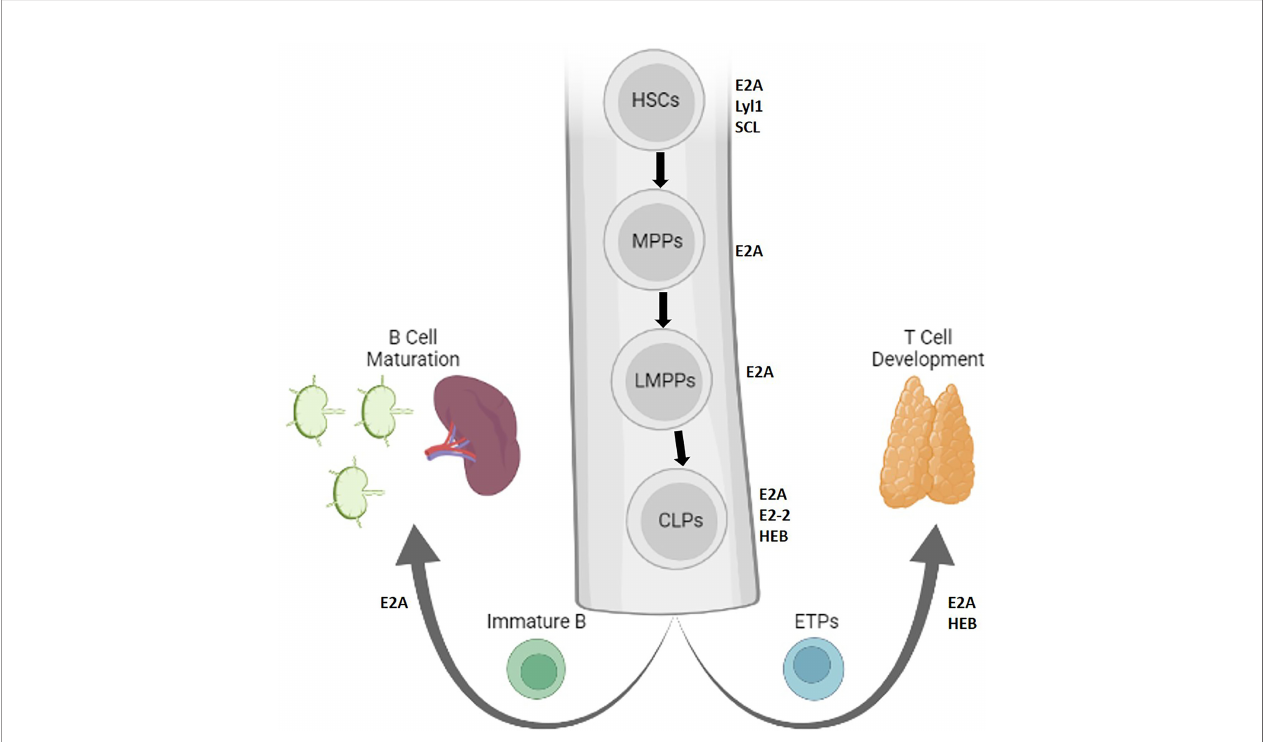
FIGURE 1 | Lymphopoiesis is directed by E protein activity in early stem cells. The role of E and Id proteins in early progenitors giving rise to B and T cells is depicted in the bone marrow. Protein factors that support stem cell maintenance or self-renewal are indicated adjacent to each cell, and bolded arrows represent lineage differentiation (Created with